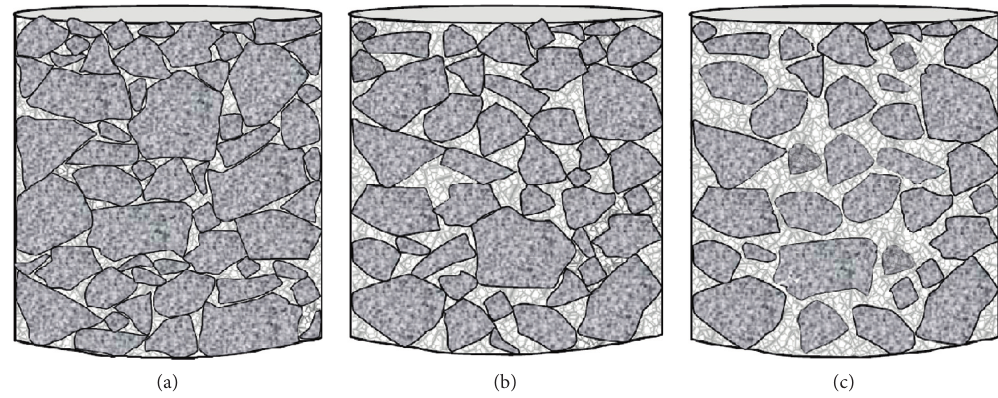
Figure 1: Skeleton state: (a) dense skeleton; (b) loose skeleton; (c) fine aggregate